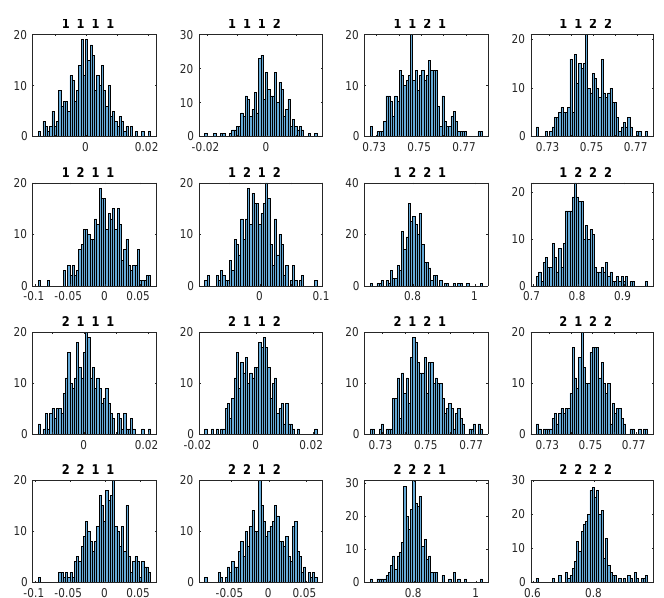
Figure A1. Histograms for all the population groups corresponding to the performance measure of the expected accuracy of the filter. Each sequence of four numbers in the figure titles represent the concrete combination of values for factors ABCD (see Table 2). The horizontal axes represent the expected accuracy in meters, and the vertical ones, the number of tests. There are 16 different groups with 304 tests each.